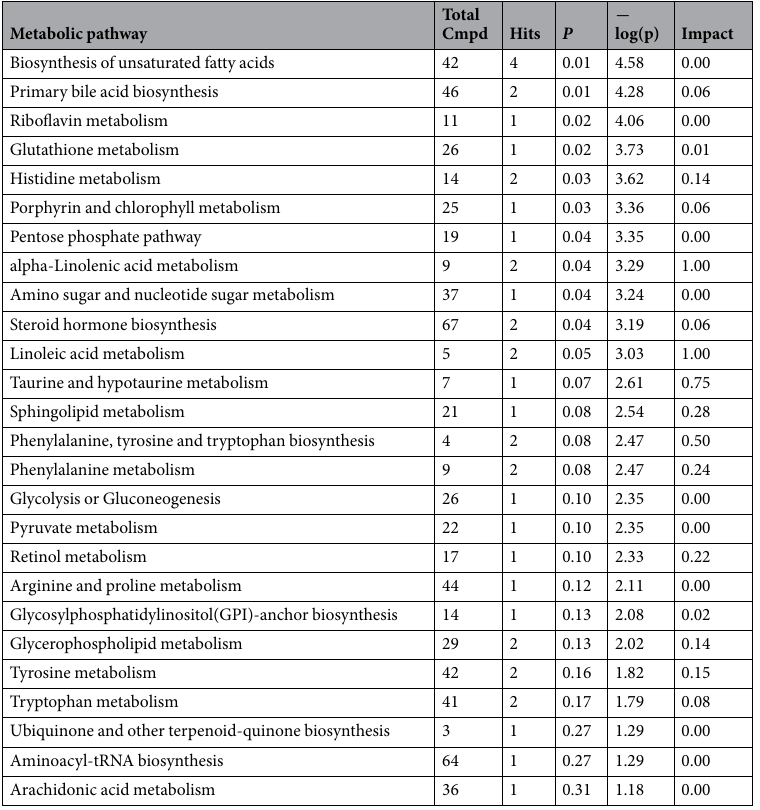
Table 2. Result from ruminal fluid pathway analysis. Total Cmpd = Total is the total number of compounds in the pathway; Hits is the actually matched number from the user uploaded data; P is the original P -value calculated from the enrichment analysis; Impact is the pathway impact value calculated from pathway topology